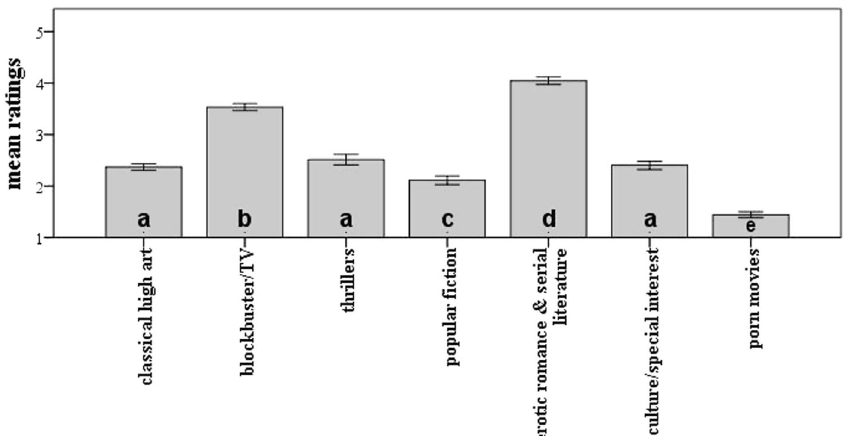
Fig. 3 Mean ratings for each of the seven components re fl ecting participants ’ cultural preferences and practices. Error bars indicate the standard error of the mean. Means with different letters are signi fi cantly different.